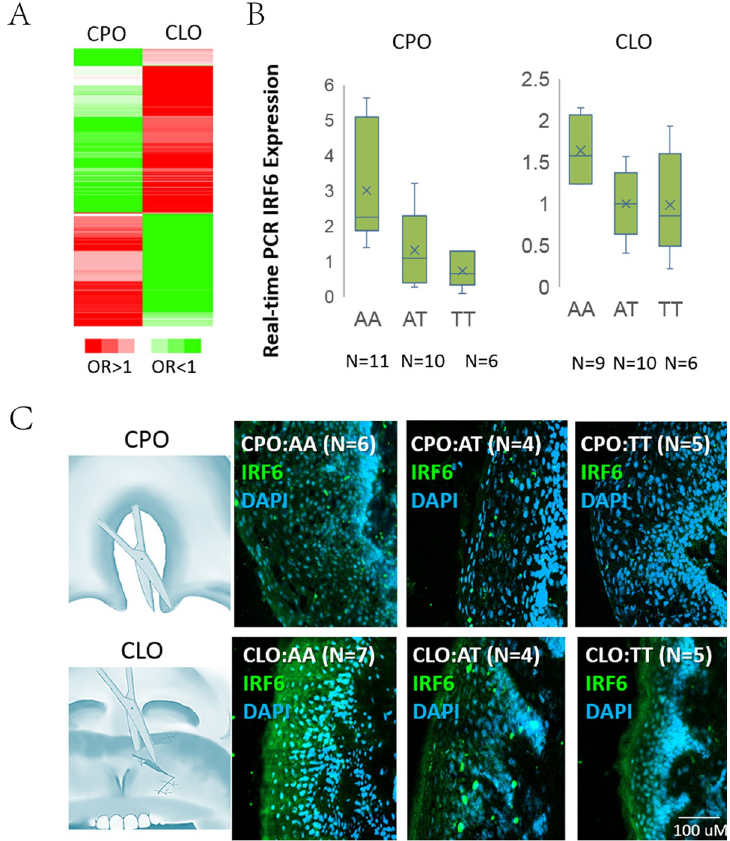
Fig 3. IRF6 gene expression in CPO and CLO affected tissues. (A) Cluster of the odds ratios of 537 significant markers ( P < 9 × 10 − 7 ) for CPO or CLO in the IRF6 locus LD in the discovery stage using Cluster 3.0. (B) Gene expression of IRF6 for rs72741048 in 1q32.2. Box plots of ratios of AA, AT genotypes comparing to TT genotype. Using real time PCR to detect gene expression in rim of uvula tissues of CPO patients and edge of upper lip cleft tissues of CLO patients. (C) Immunofluorescence of IRF6 in affected tissues. Left panels: IRF6 (green) was expressed in the tissues from the rim of the uvula of CPO patients (upper) and edge of the upper lip cleft of CLO patients (lower panel). Right panels: Box plots of ratios of fluorescence values of AA and AT genotypes comparing to TT genotypes. Fluorescence values were measured with ImageJ software.